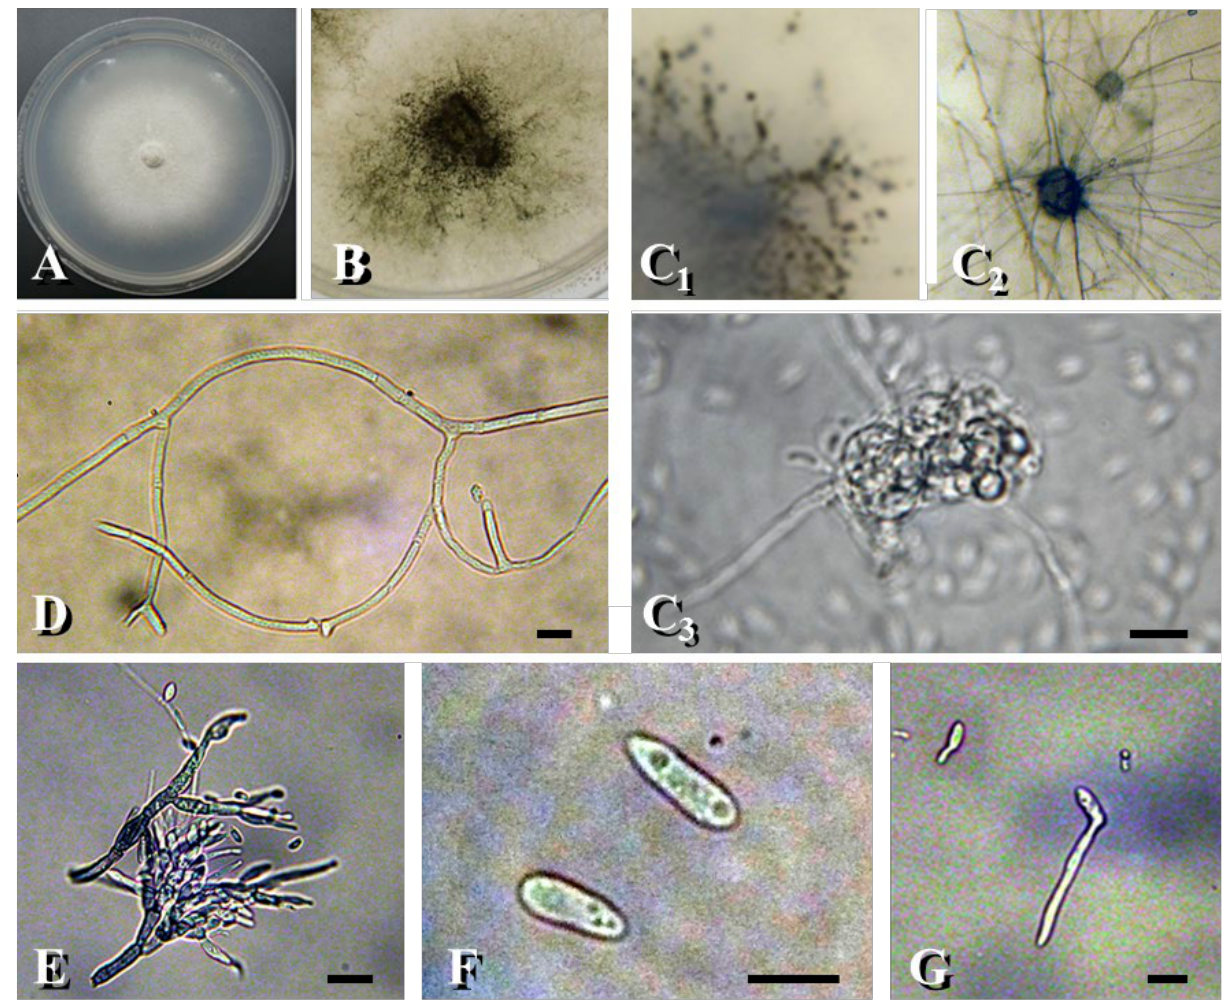
Figure 1. Morphological and microscopic characterization of Harpophora maydis strain Hm-3. A , A young colony (6 d old on PDA); B , mature colony (12 d old) exhibiting a “rhizoidal” or “hyphal rope” appearance; C , Sclerotium-like bodies formed in old cultures (44 d old) of H. maydis on PDA, seen as spots from the back of the Petri dish (C 1 ), magnified on the culture surface (C 2 ), and at high magnification in a slide preparation (C3); D , bent marginal hyphae; E , two conidiophores; F , conidia; G , germinating conidia after 6 h of incubation. All cultures were grown at 28°C under continuous light from cool-white fluorescent tubes. The bar markers represent 10